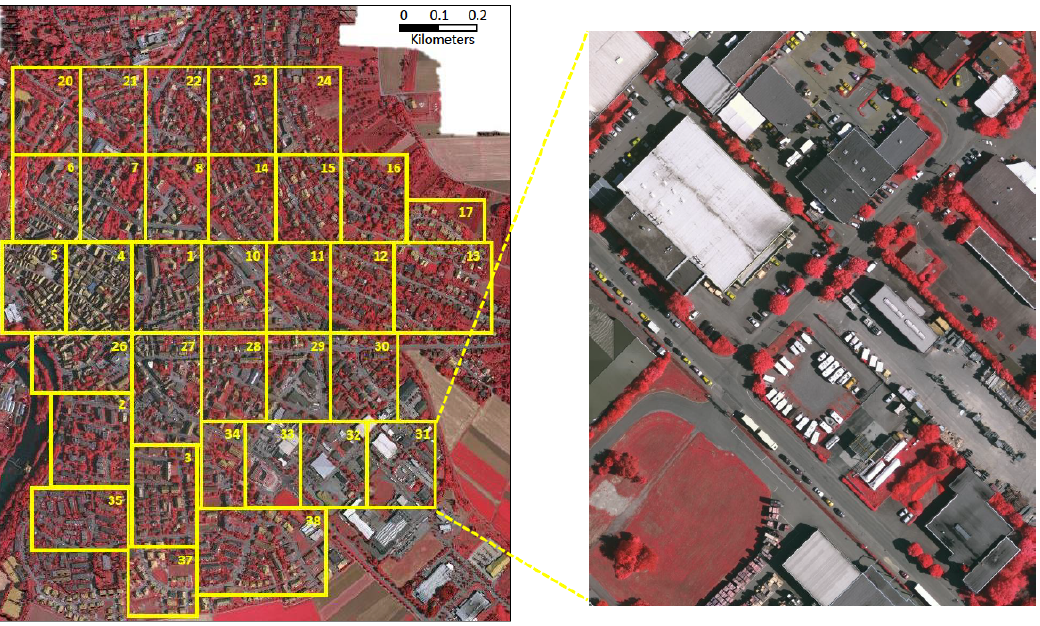
Figure 8. ISPRS 2D Vaihingen segmentation corpus (33 scenes).